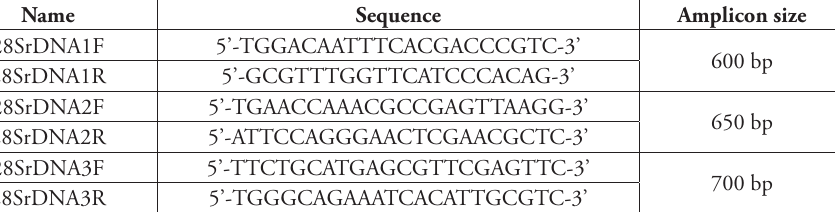
Table 1. Primers used for 28S rDNA amplification.